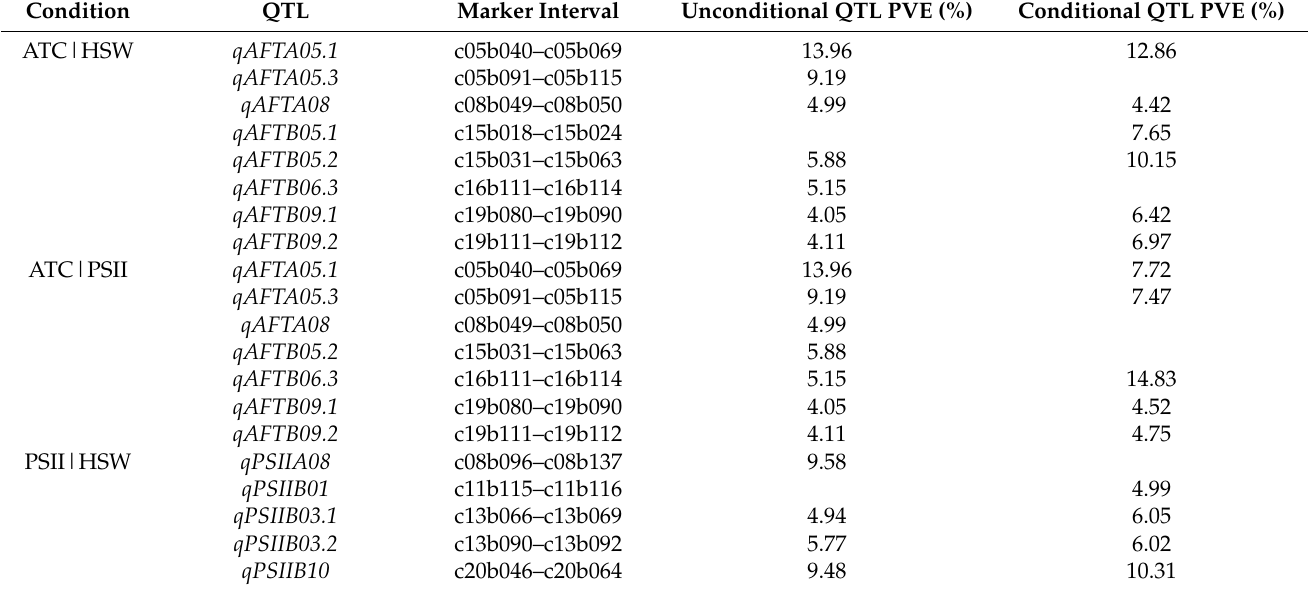
Table 5. Comparison of unconditional and conditional QTLs for ATC and HSW in the RIL popula- tion.